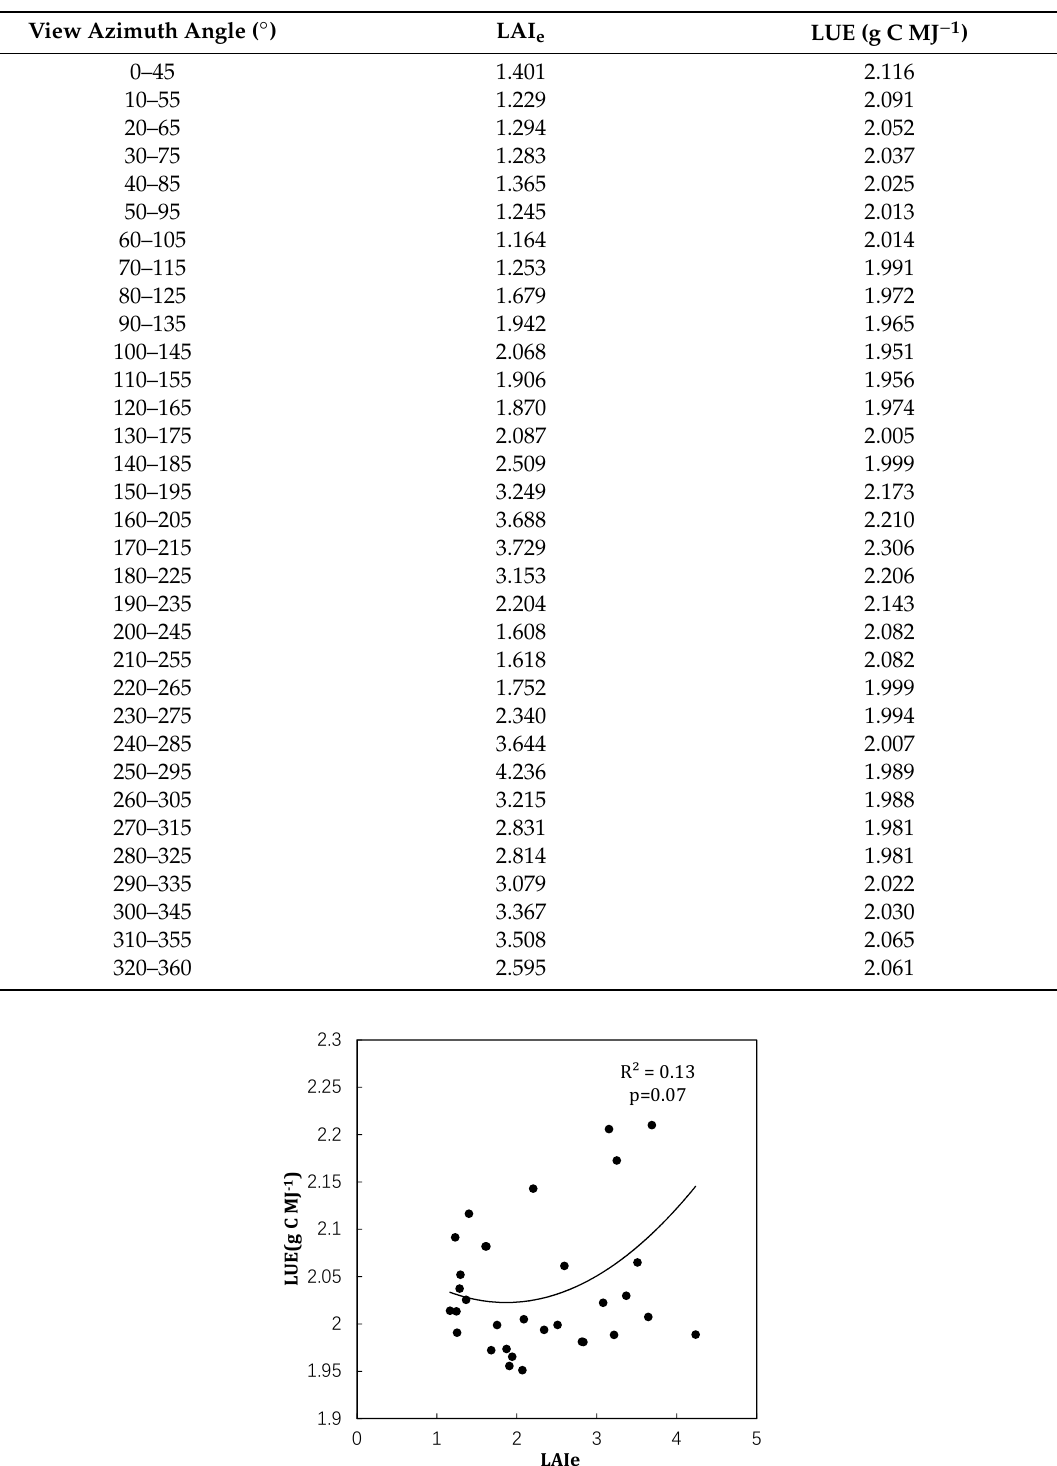
Table 3. Distribution of gap fraction, LAI e , and LUE in di ff erent azimuth angles.